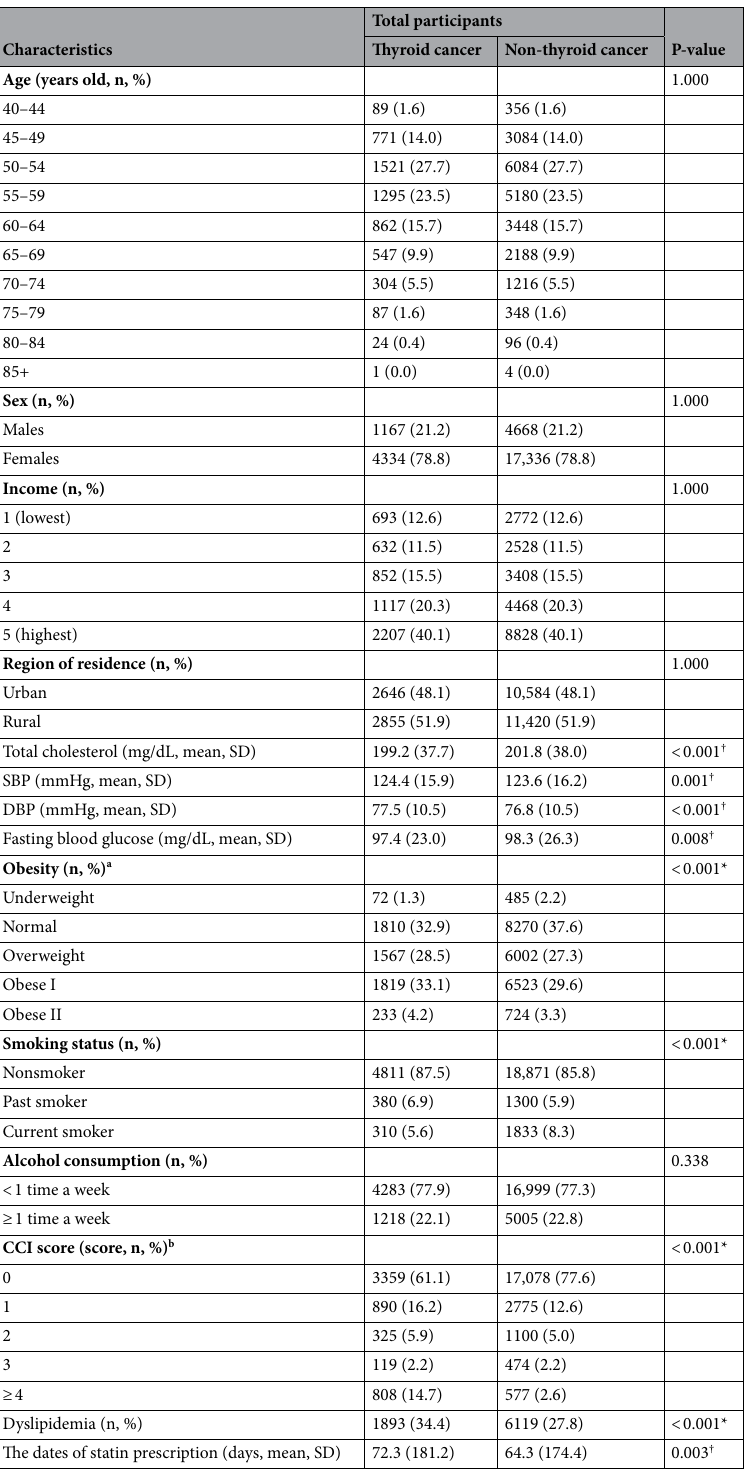
Table 1. General characteristics of participants. CCI Charlson comorbidity index, DBP diastolic blood pressure, SBP systolic blood pressure, SD standard deviation. *Chi-square test. Significance at P <